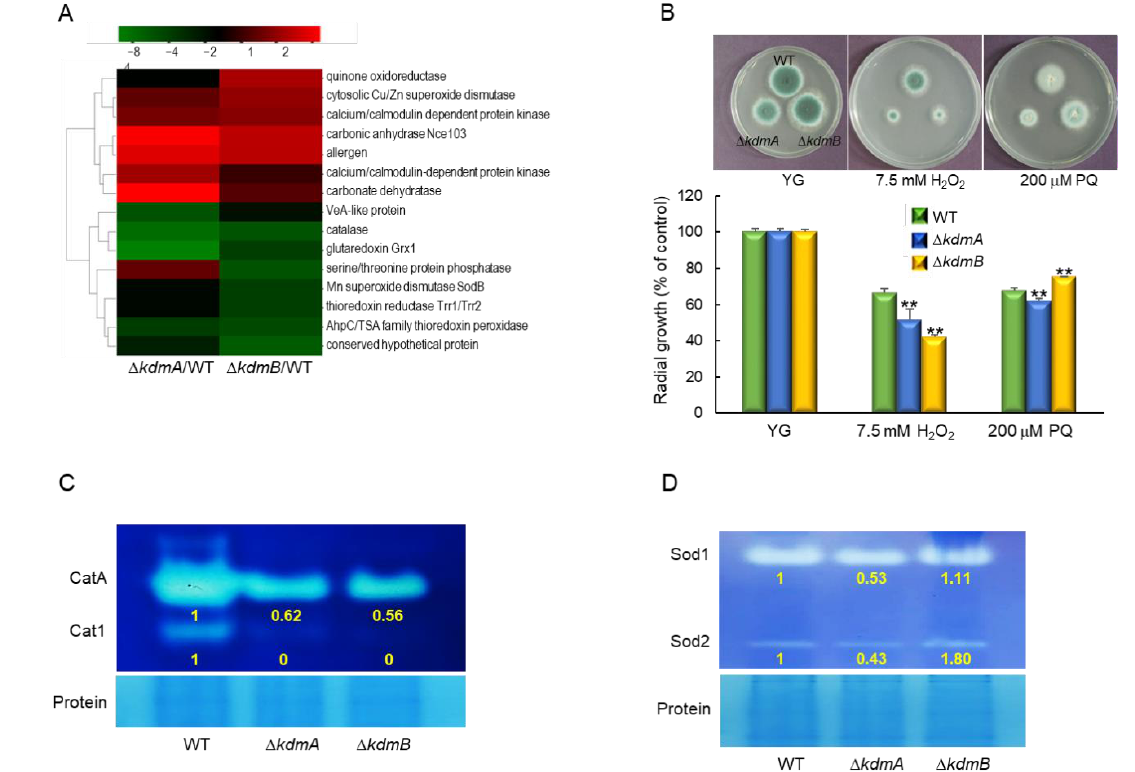
Figure 3. Distinct responses of ∆ kdmA and ∆ kdmB mutants to various kinds of oxidative stress. ( A ) Heatmap of altered expression levels of genes encoding oxidative stress-related proteins in ∆ kdmA and ∆ kdmB mutants. ( B ) Colony appearance and radial growth inhibition after inoculation of 1 × 10 5 conidia on solid YG medium containing oxidative stressors. ( C ) Catalase activity of the WT and mutant strains. ( D ) SOD activity of the WT and mutant strains shown in non-denaturing polyacrylamide gels. Relative intensities of each enzyme’s activity are shown below. Statistical significance of differences between WT and mutant strains was evaluated using Student’s t -test: ** p <